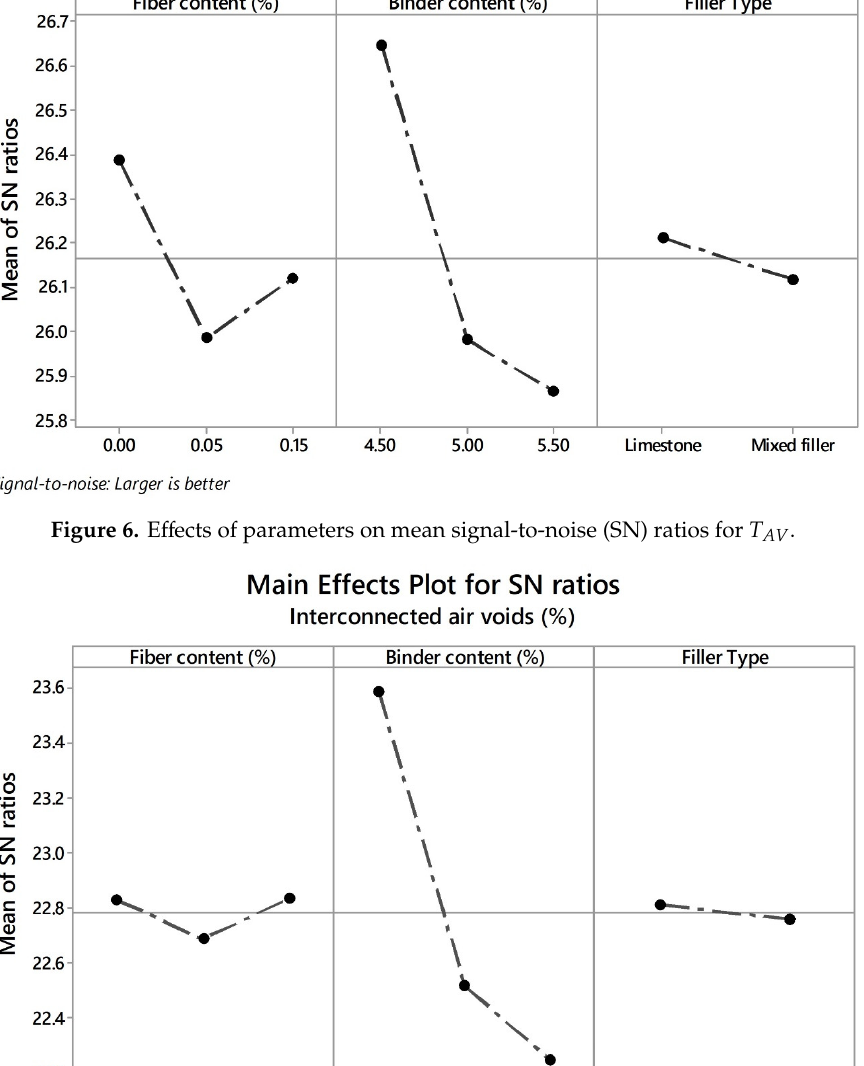
Figure 7. Effects of parameters on mean SN ratios for (cid:1835) (cid:3002)(cid:3023) . Figure 7. E ff ects of parameters on mean SN ratios for I AV